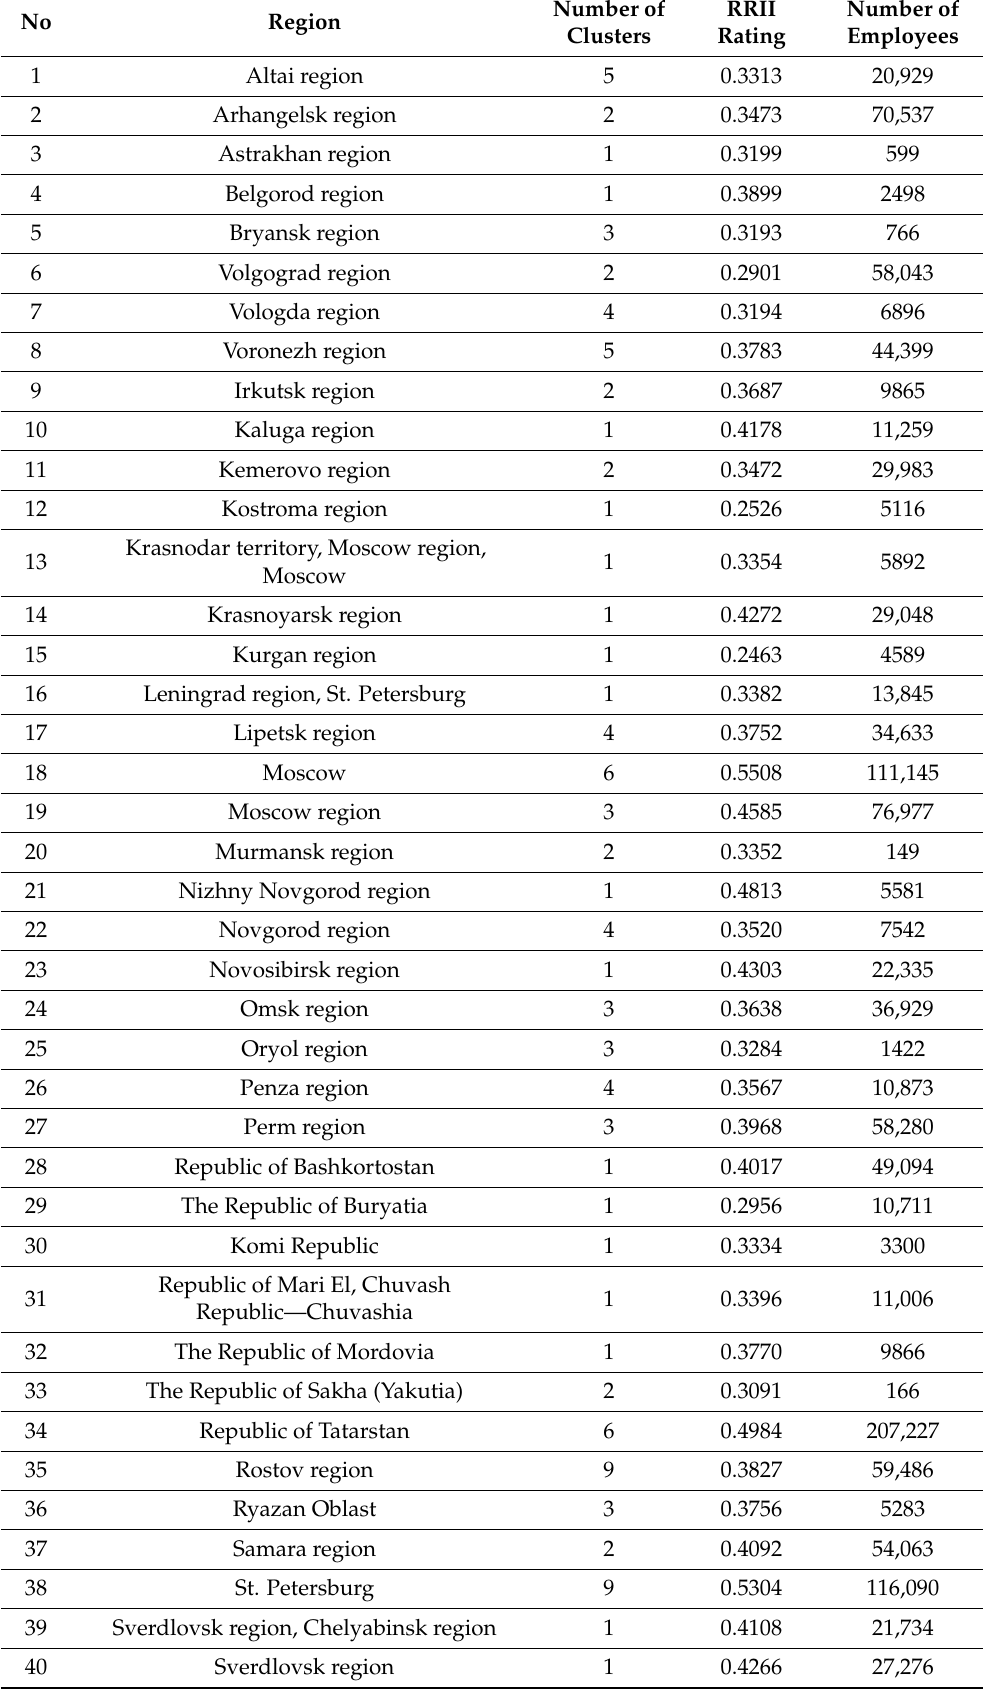
Table 2. Distribution of regions in Russia with clusters; the data have been adapted from Refs.